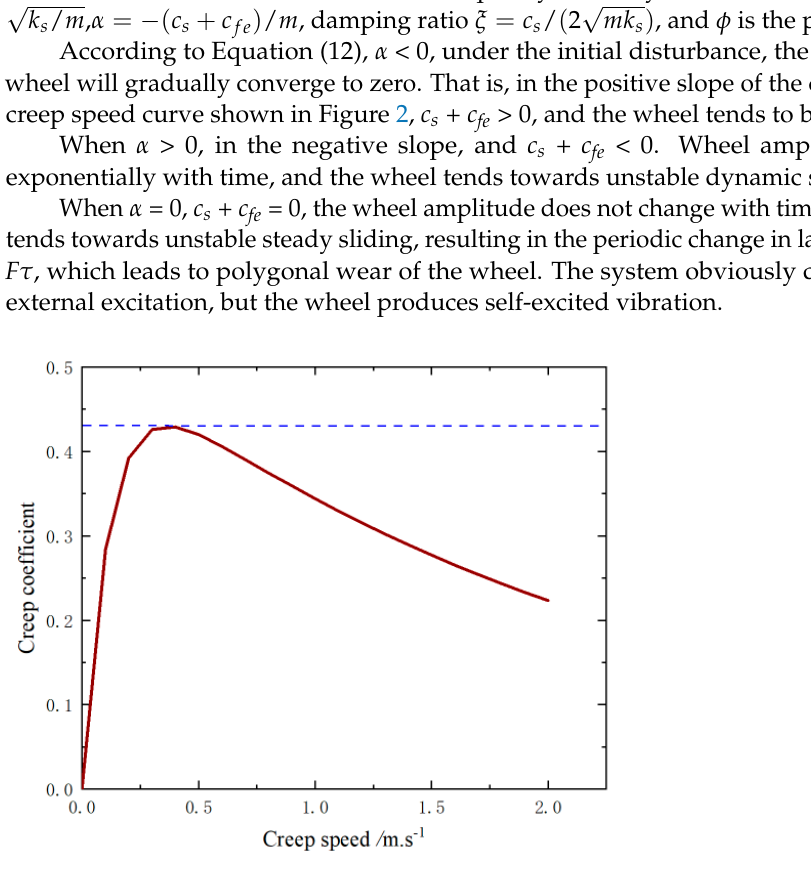
Figure 2. Relationship curve between creep speed and creep coefficient of wheel-rail contact.